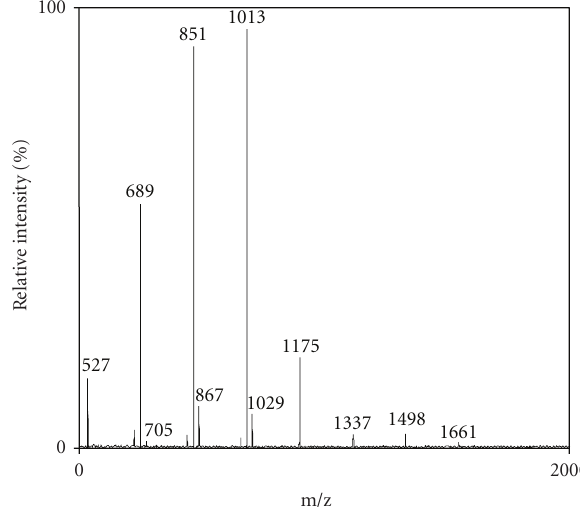
Figure 2: MALDI MS spectrum of a standard solution (x mg mL − 1 ) of Raftilose. DHB was used as matrix. “a.i.” means arbitrary inten- sity and “m/z” means the mass-to-charge ratio. Other conditions as reported in Section 2.4.